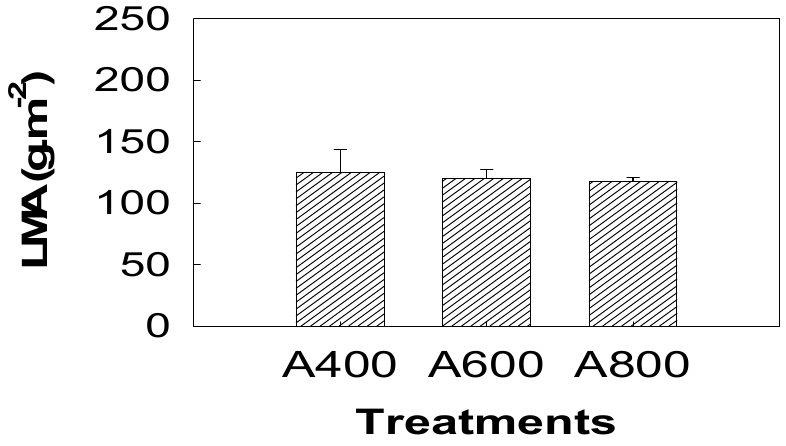
Figure 2. Effects of elevated CO 2 (A400—400, A600—600, and A800—800 µL L − 1 ) on leaf mass per area (LMA) of red maple ( Acer rubrum L.). The values shown are mean ± SD. There were no significant differences among (CO 2 ) treatments when p < 0.05, n = 3.